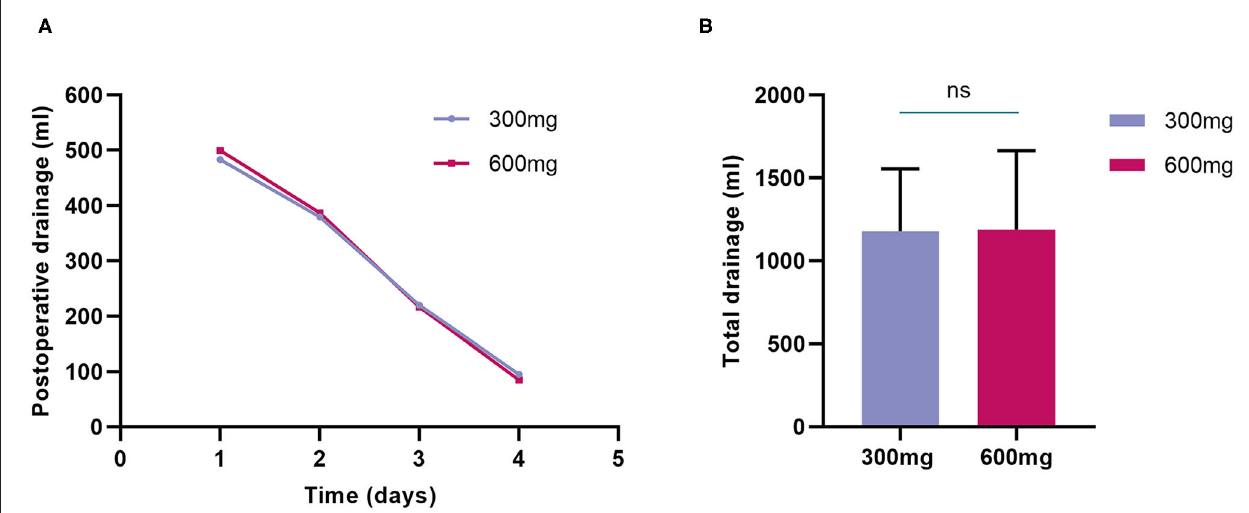
FIGURE 2 | Postoperative drainage of randomized groups. (A) Postoperative mean chest drainage of the first 4 days was comparable between the two groups; (B) Total drainage volume was also similar between clopidogrel 300-mg group and 600-mg group.